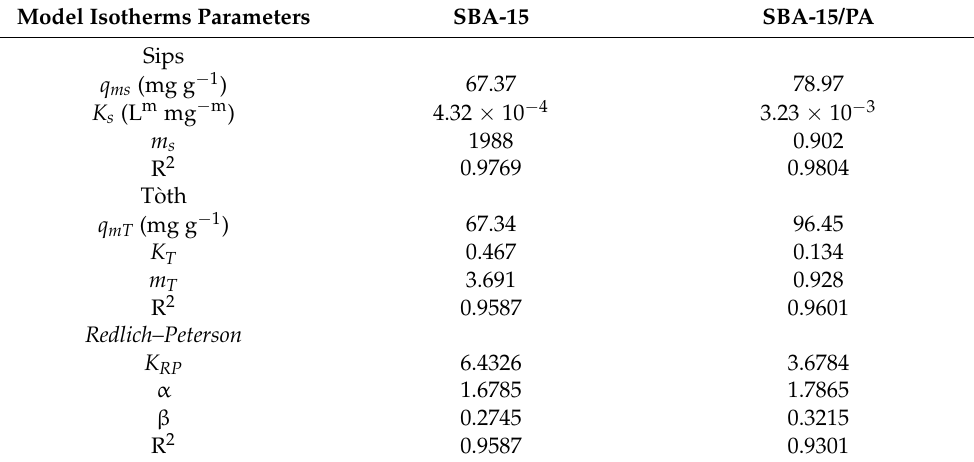
Table 5. Sips, T ó th and Redlich–Peterson (three-parameter isotherms) parameters on silica and its